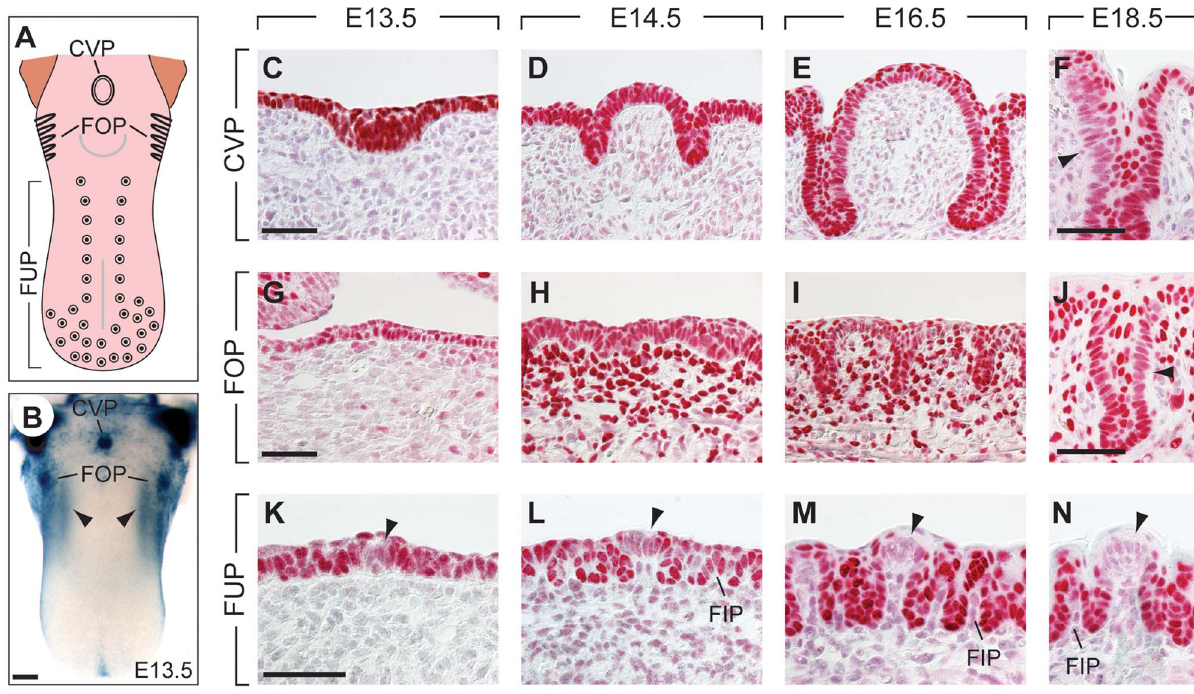
Figure 1. Expression patterns of Pax9 in different taste papillae of the embryonic mouse tongue. ( A ) Drawing showing the localization of the circumvallate papilla (CVP), foliate papillae (FOP), and fungiform papillae (FUP) in the mouse tongue. ( B ) Whole mount X-Gal staining of a Pax9 + /LacZ mouse tongue at embryonic day 13.5 (E13.5). Note that expression is also seen in the mesenchyme adjacent to the developing FOP (arrowheads) and that the color reaction was stopped before epithelial staining began to obscure the mesenchymal expression domain. ( C–N )